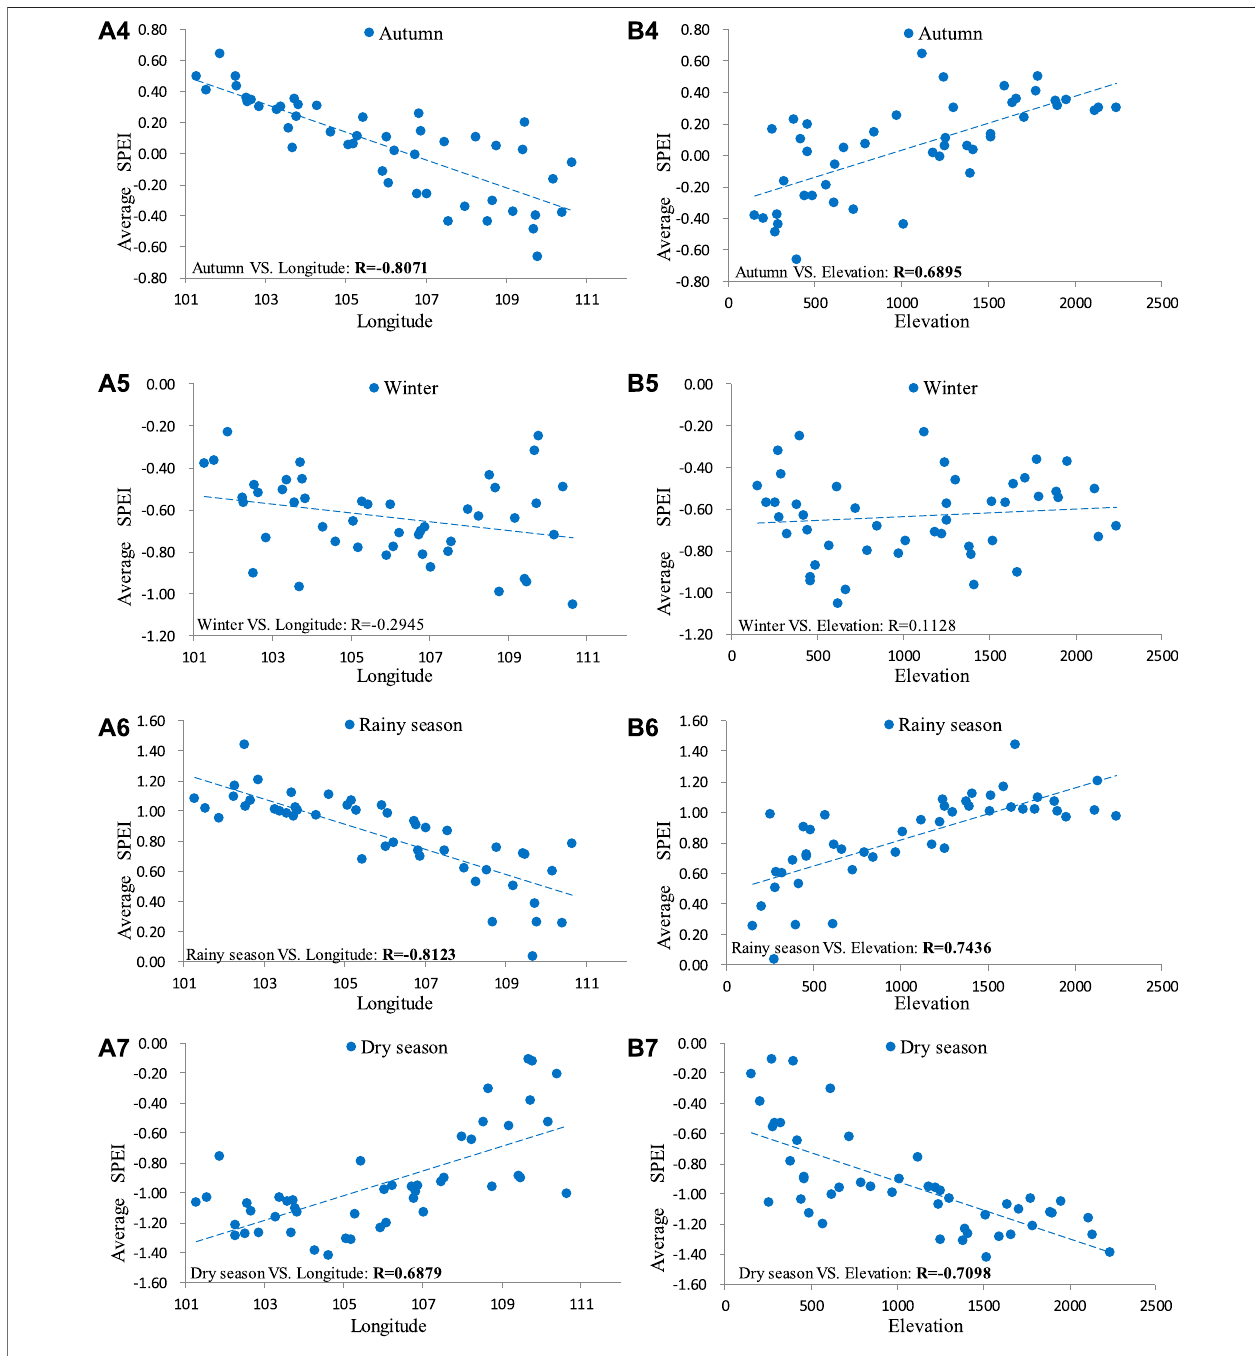
PCA is a widely used spatiotemporal analysis method. It can use a few linearly uncorrelated principal components to explain most of the total variance in the original data according to the calculation results of the covariance matrix and corresponding eigenvalues and eigenvectors (Raziei et al., 2009) without causing extreme loss of